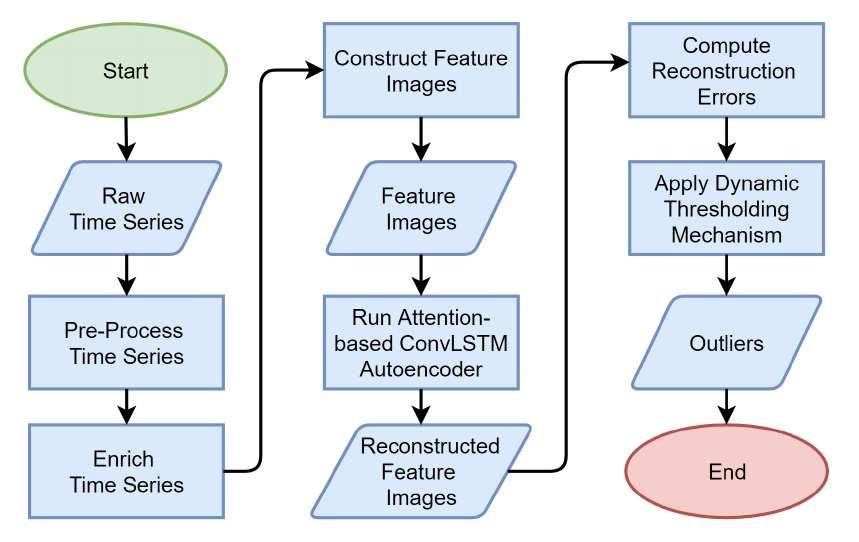
Figure 3. ACLAE-DT